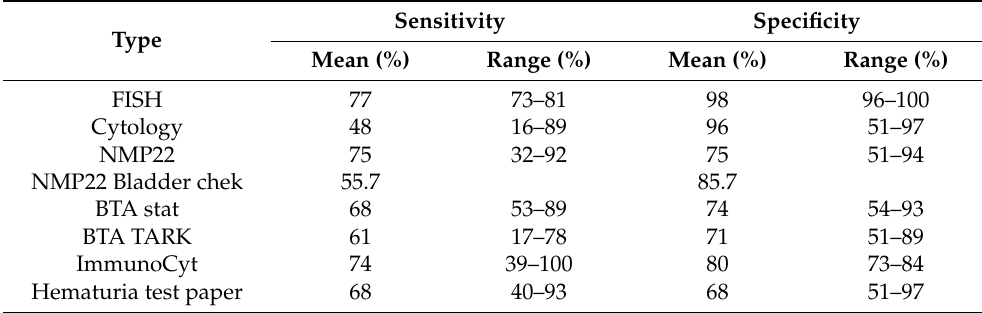
Table 2. Comparison of the performance of FISH with other non-invasive detection